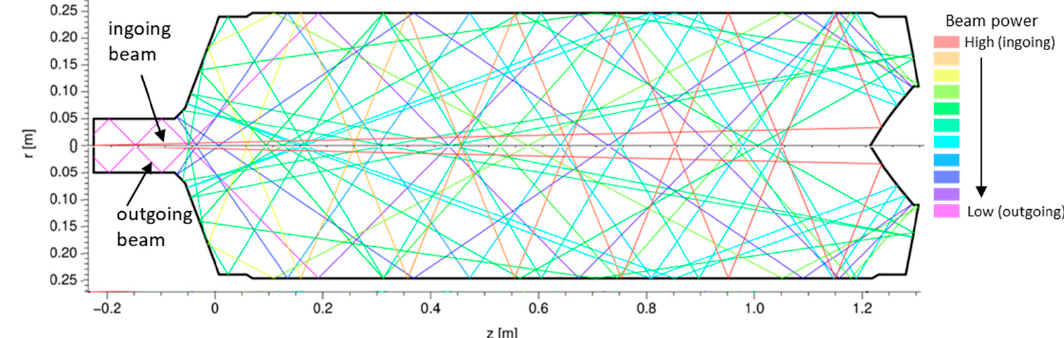
Figure 2. Trace of a single ray starting at the input position (on-axis) with a very shallow angle and propagating through the proposed load geometry. The loss of power is qualitatively indicated by the color (starting from red to magenta, refer to caption on the right side).